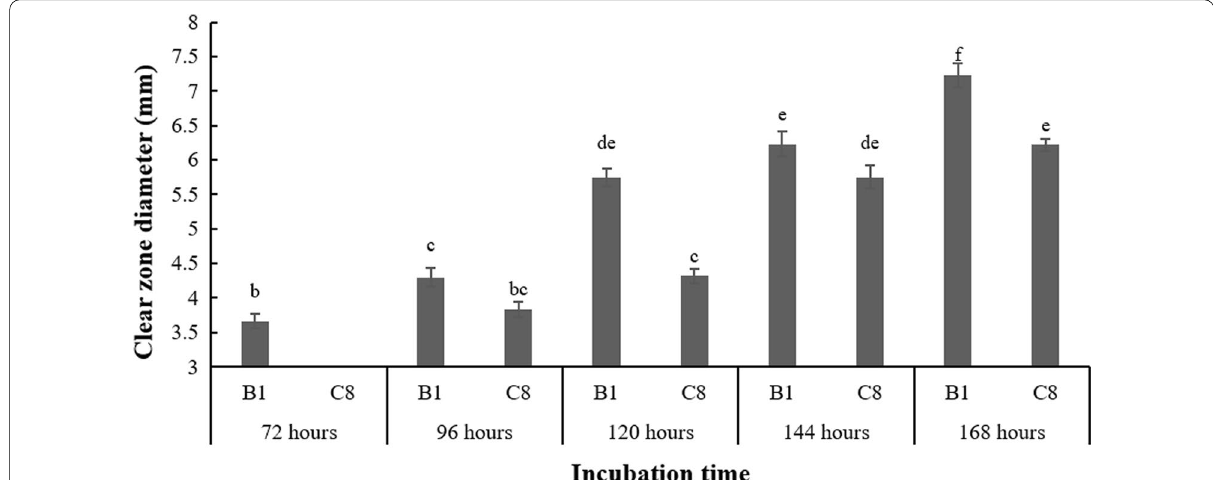
Fig. 3 Inhibitory activities of the CFS B1 and C8 bacterial isolates at different culture ages. Different letters on each histogram indicated any difference in clear zone diameter among bacteria isolates and culture age ( p <